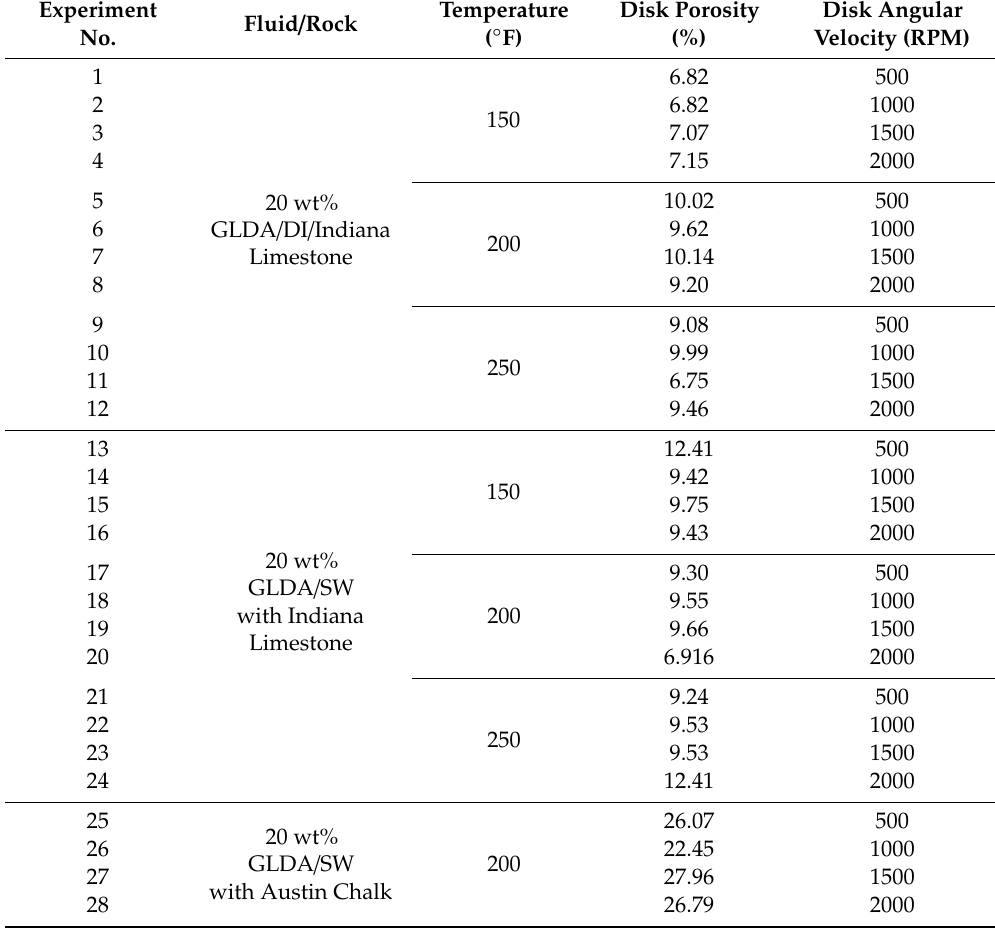
Table 3. Experiments using GLDA with Indiana limestone and Austin chalk calcite